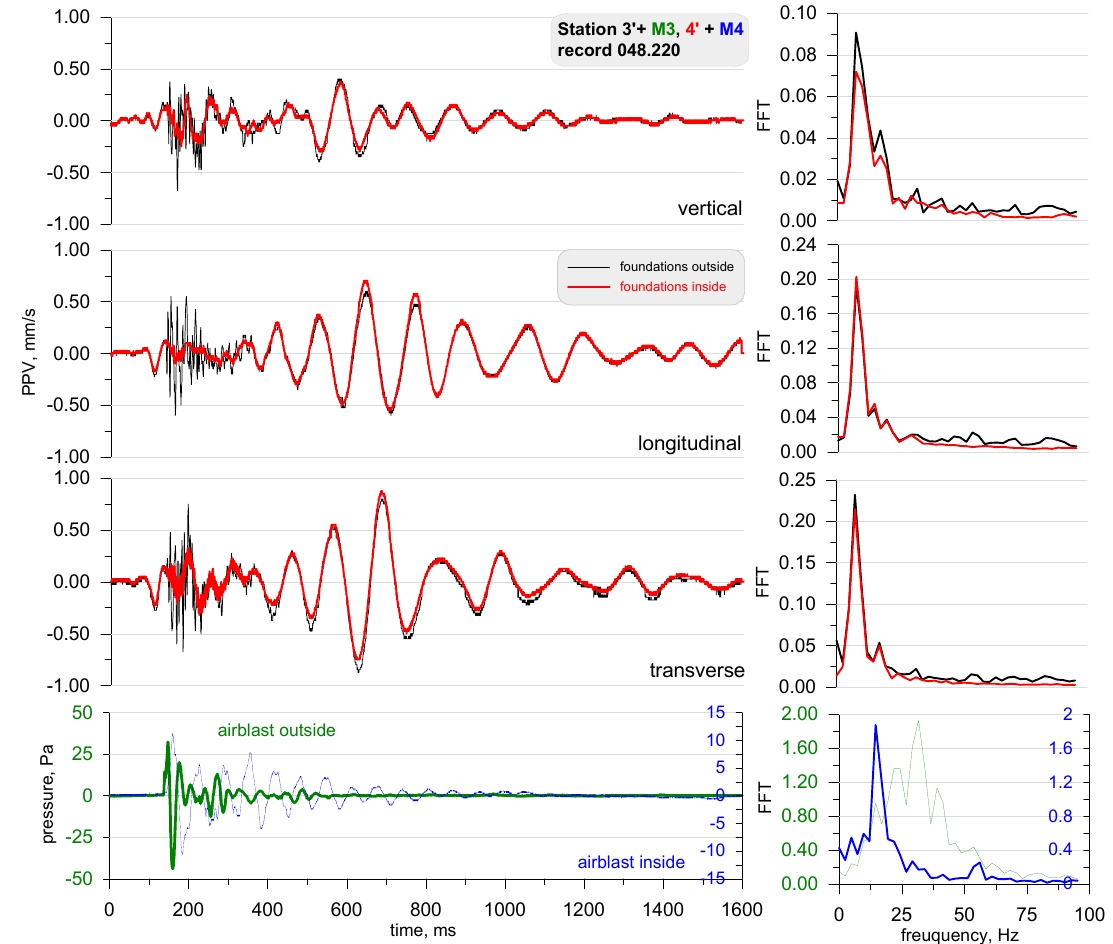
Figure 23. Foundation vibration seismogram (three directional components) and recordings of airblast wave pressure combined with the analysis of the FFT-Station 3 and 4—buried explosive charge.